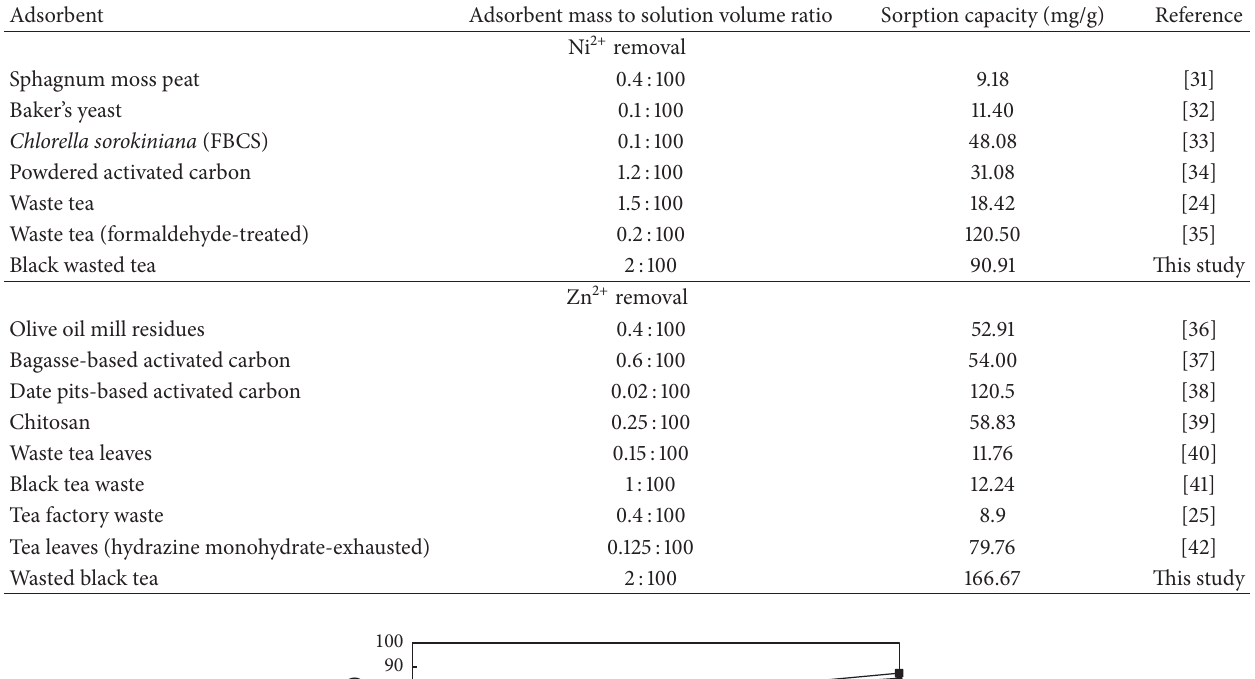
Table 4: The capacity of different adsorbents for Ni 2+ and Zn 2+ removal.